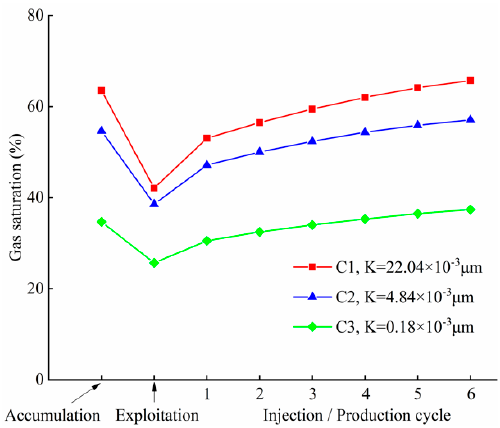
Figure 8. Variation curve of gas saturation in the gas-drive-water gas zone.